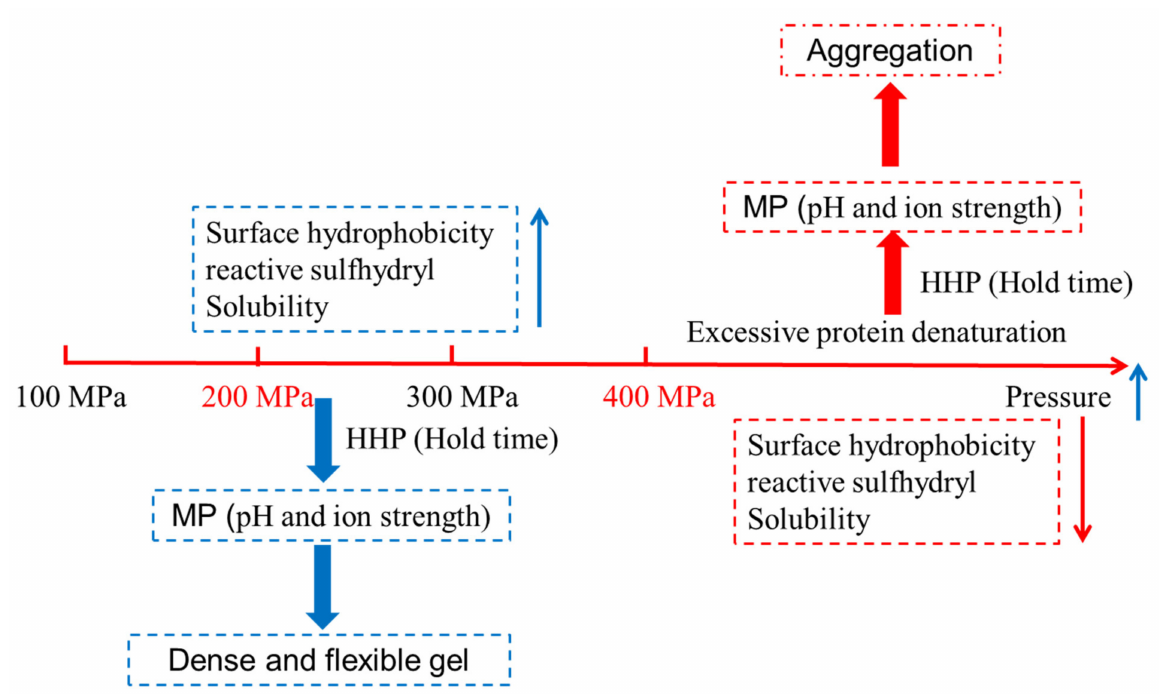
Figure 2. Schematic diagram of the mechanism of pressure-induced protein